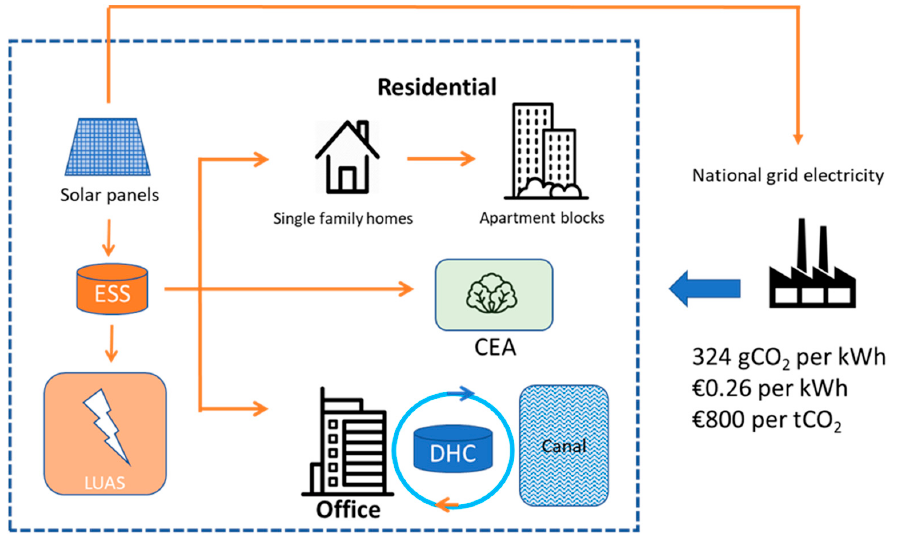
Figure 5. A conceptual diagram of the neighbourhood study area (marked by the dashed box) and the local resources available. Shown here is the Energy Storage System (ESS) and the Controlled Environmental Agriculture (CEA) and District Heating and Cooling (DHC) systems that connect users.